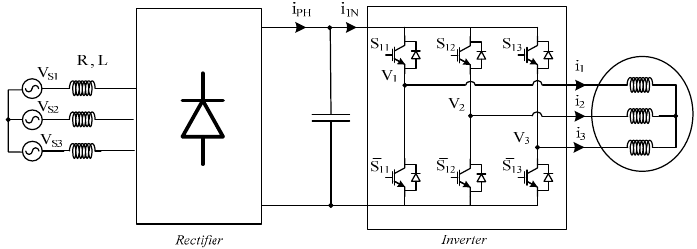
Figure 1. Classical AC VSD (Variable Speed Drive).